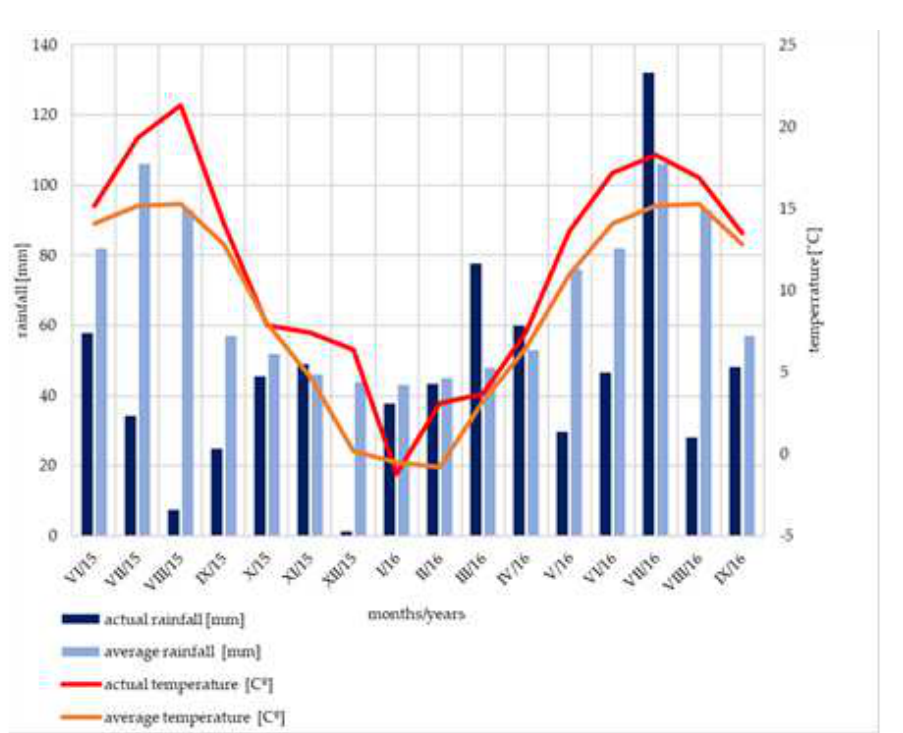
Figure 5. The average rainfall [mm] and temperature [°C] and actual rainfall [mm] and temperature Figure [°C] in Muchów Forest Nursery, Poland (I—January; II—February, III—March etc.). The rate of easily accessible water in the soil was verified at 7.7% of the soil volume. Average daily water consumption for evapotranspiration (similar to ETo) was assumed to be 2.3 mm. High annual precipitation exceeding 610 mm [56]. The preferable depth for dampening the soil was established at 15 cm in both years of the experiment. The net d = 0.1 × Wd × h [mm], where Wd—water content readily available in % of soil volume; h—the desired depth of soil moistening. The gross irrigation dose (d) was calculated according to the formula: D = d/k e [mm],